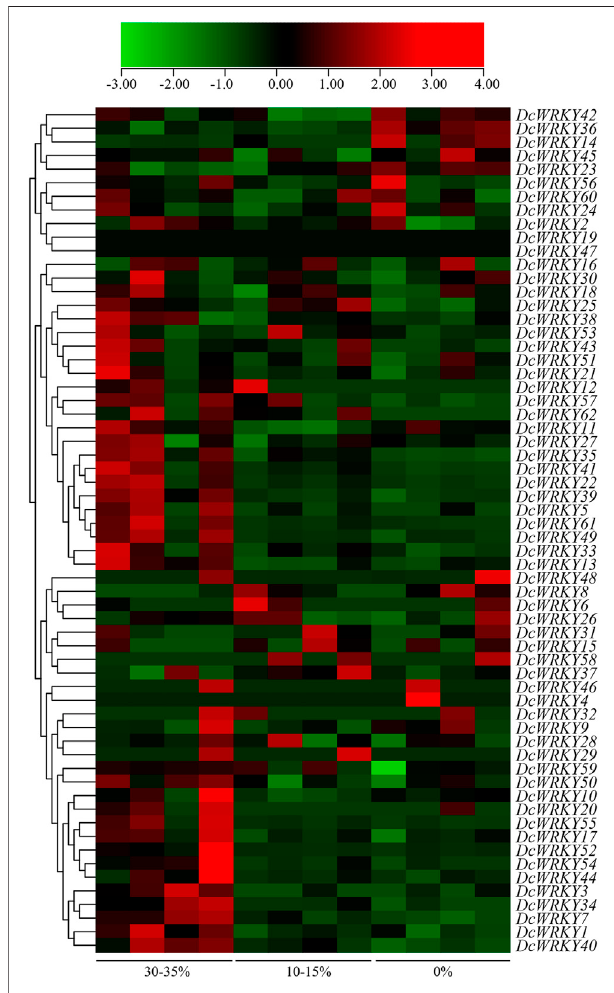
FIGURE 4 | Heat map of DcWRKY genes under different volumetric water contents of the base material. Data were normalized relative to each gene ’ s mean expression value across all treatments and log2-transformed. TPM values were used to create heat map showing the expression of DcWRKY genes. The expression level ranges from low expression (green) to high expression